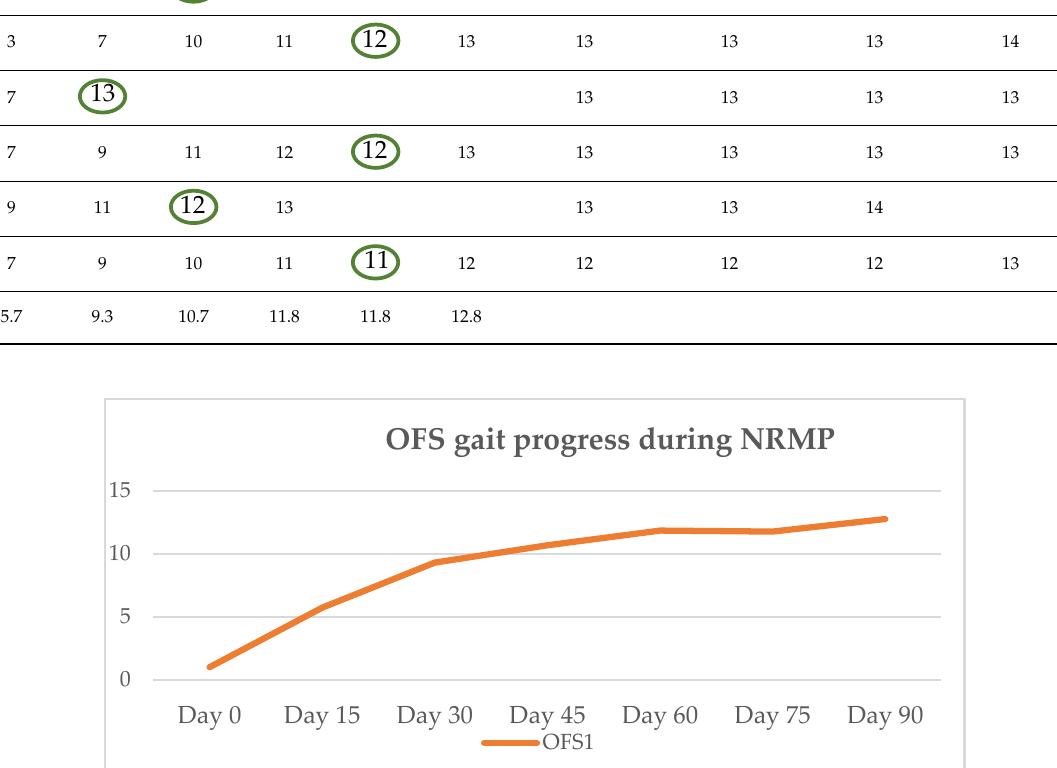
Figure 6. Mean OFS gait progression of OFS 1 dogs during NRMP. OFS—open field score [64]; NRMP—neurorehabilitation multimodal protocol.